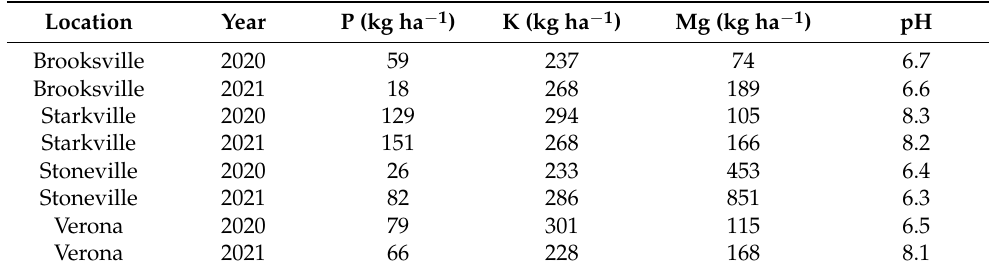
Table 1. Phosphorus (P), potassium (K), and magnesium (Mg) soil test results in kg ha − 1 and soil pH 0 to 15 cm for Brooksville, Starkville, Stoneville, and Verona in 2020 and 2021 before nutrient amend- ments.